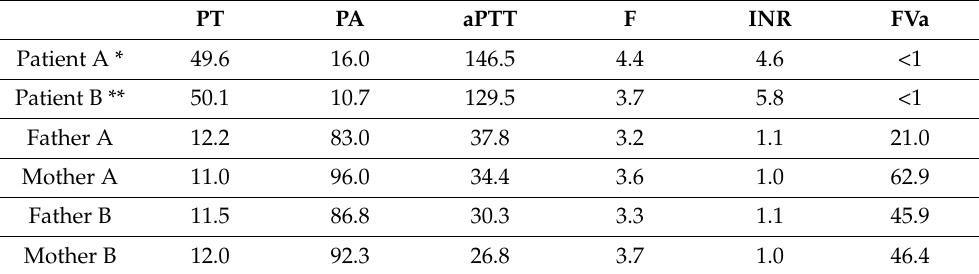
Table 1. Coagulation parameters and factor V